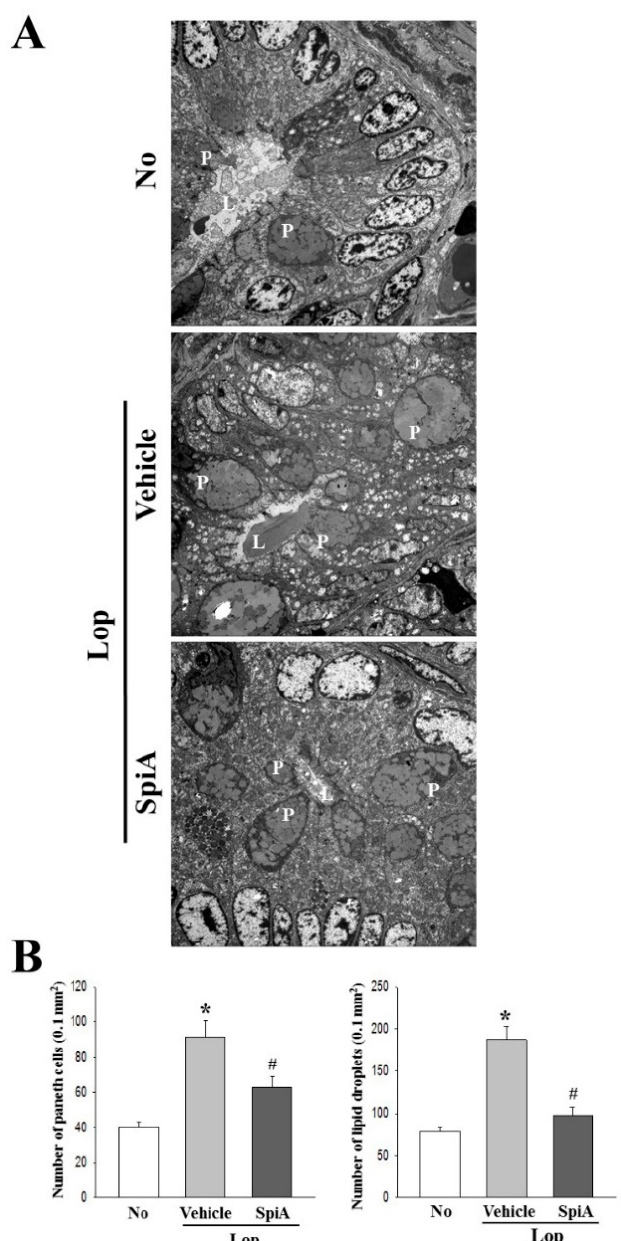
Figure 2. TEM images of colons of mice. ( A ) Crypt ultrastructure of colon in the No, Lop + Vehicle and Lop + SpiA treated groups were observed by TEM at 1800 × magnification. ( B ) Crypt lumen diameter, number of Paneth cells, and number of lipid droplets were determined using the Leica Application Suite software. Four to five mice per group were used in preparation of TEM slide and two parameters were assayed in duplicate in each test. Data are reported as the mean ± SD. *, p < 0.05 compared to the untreated group. # , p < 0.05 compared to the Lop + Vehicle treated group. No, Untreated group; Lop, Loperamide; SpiA, Spicatoside A; TEM, transmission electron microscopy; L, crypt lumen; P, Paneth